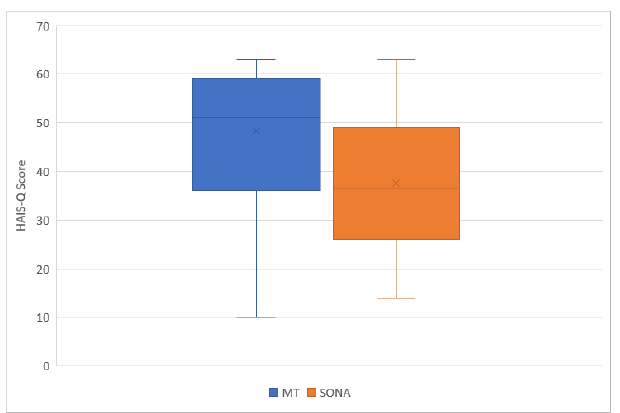
Figure 12. HAIS-Q scores for MTurk vs SONA.